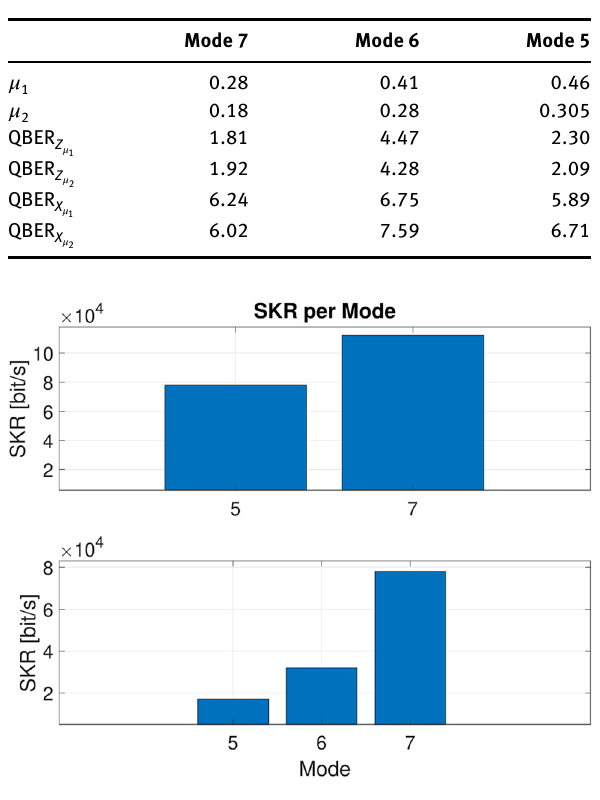
Figure 4: Secret key rate experimentally achieved for the 2-mode (top) and 3-mode (bottom) multiplexing.